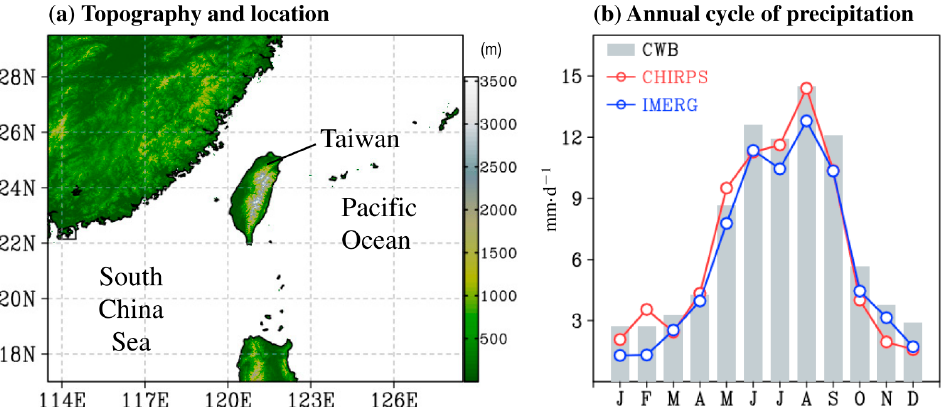
Figure 1. ( a ) Location and topography of Taiwan, ( b ) annual cycle of 19-year mean (2001–2019) of monthly precipitation (area-averaged) over Taiwan. In ( b ), the gray bar, red line, and blue line represent the estimation of precipitation from CWB, CHIRPS, and IMERG, respectively. Hereafter and in this figure, alphabets J to D (left to right on the x -axis) represent the months from January to December.